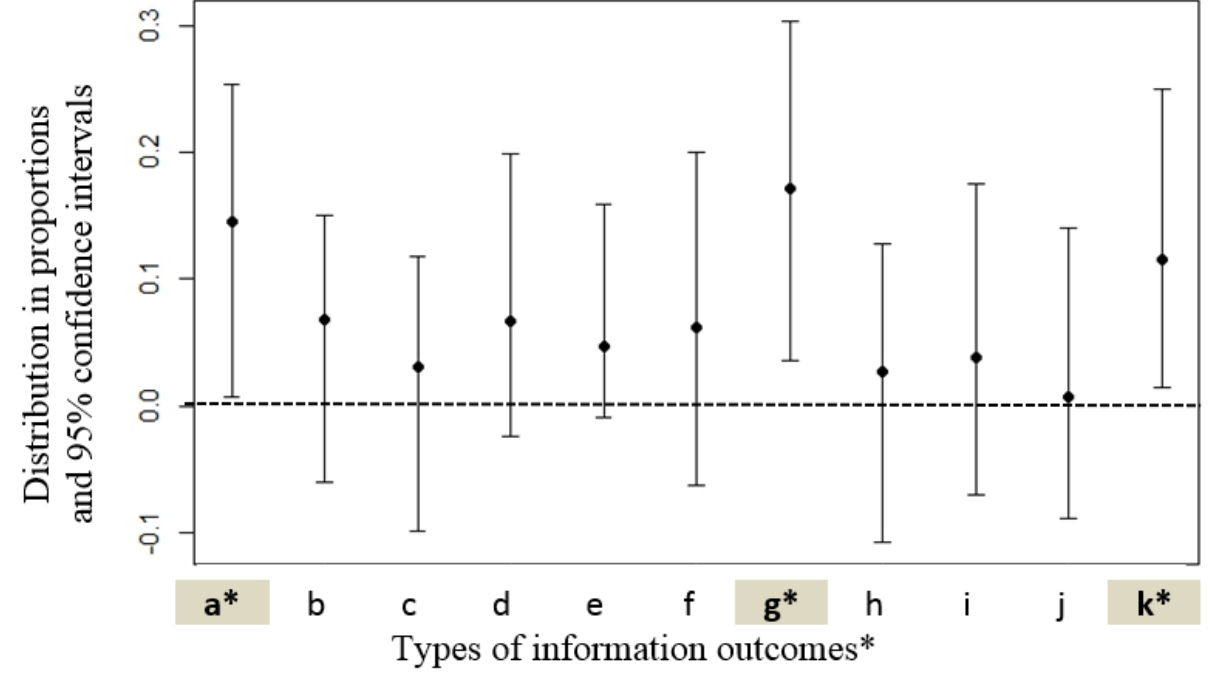
Figure 3. Types of information outcome: differences in proportions comparing the Information Assessment Method ratings of participants combining low education and low income versus other